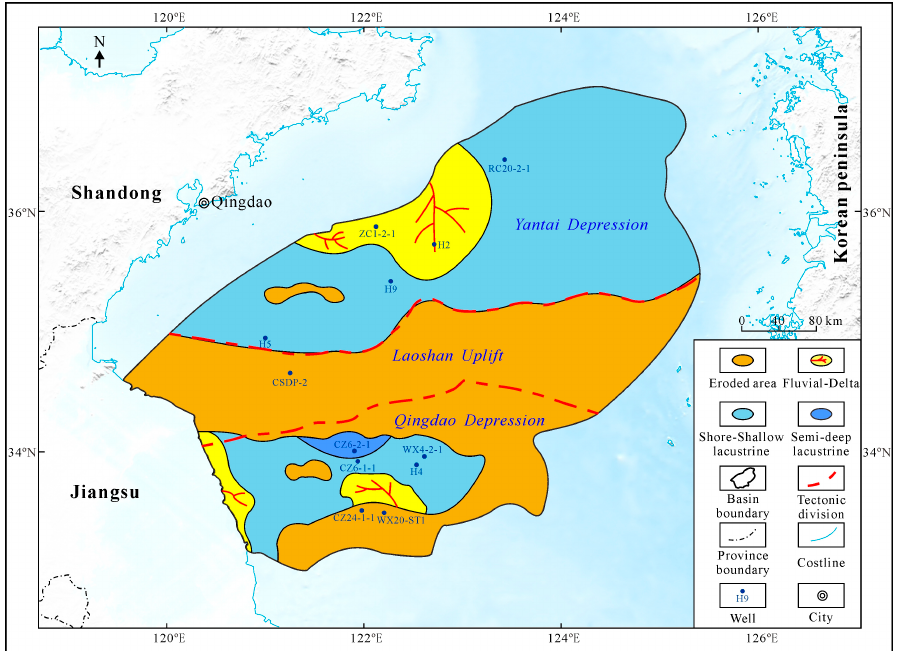
Figure 7. Sedimentary facies of the Eocene Dainan Formation in the South Yellow Sea Basin (compiled from Zhu et al. [54]; Qi [59]; and Zhang et al. [73]). Table 1. Formulas and data sources of the calculation parameters used in this